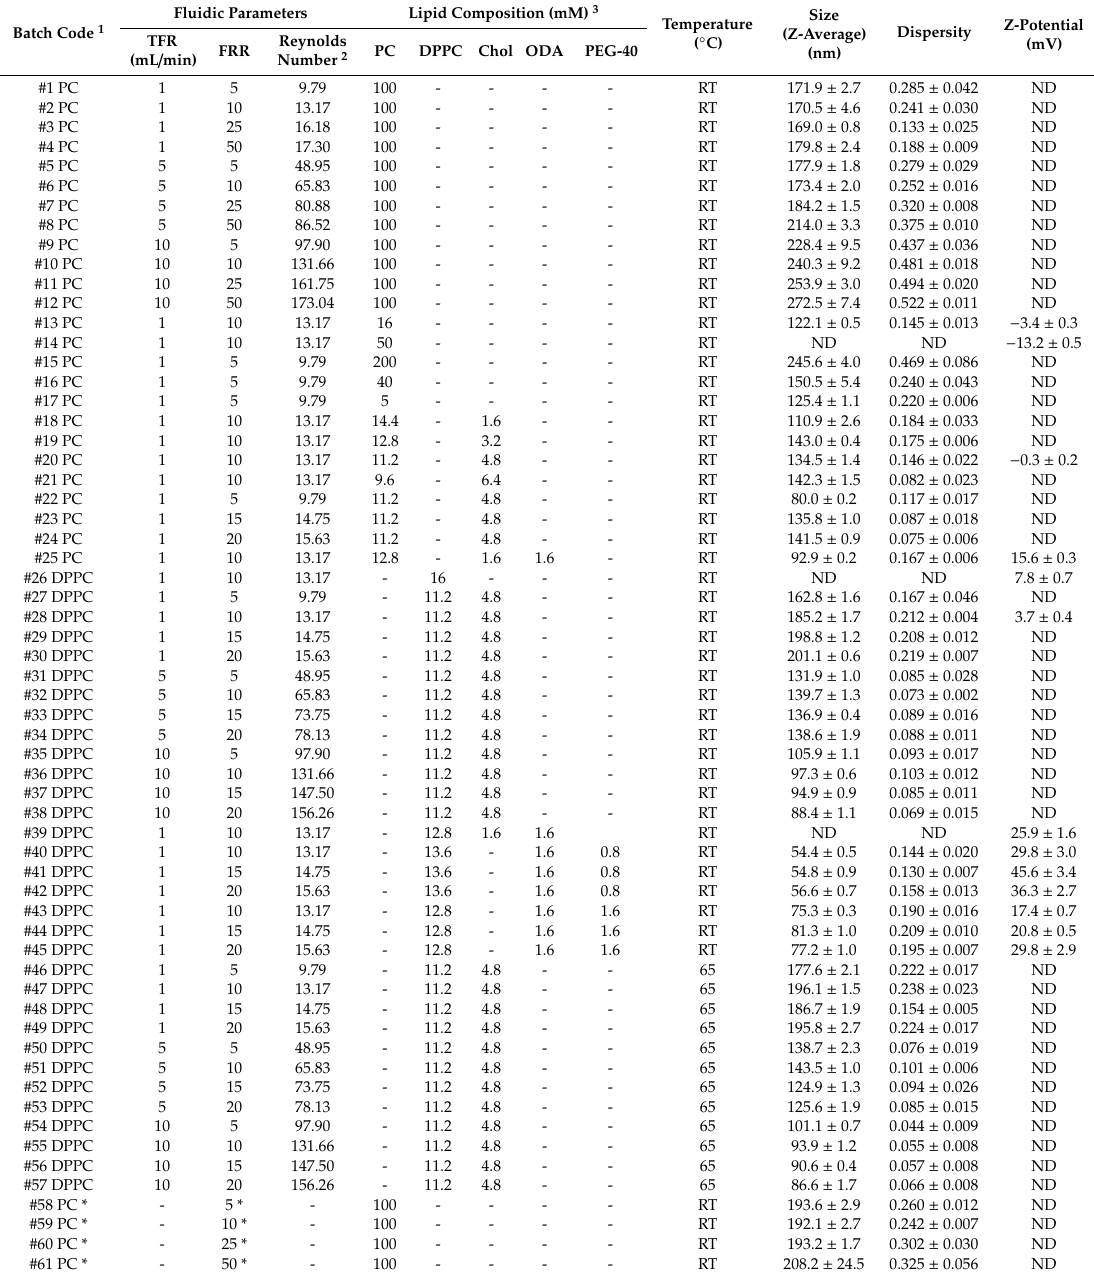
Table 1. The operational parameters (flow rate ratio (FRR), total flow rate (TFR), and temperature) and chemical formulations used in each